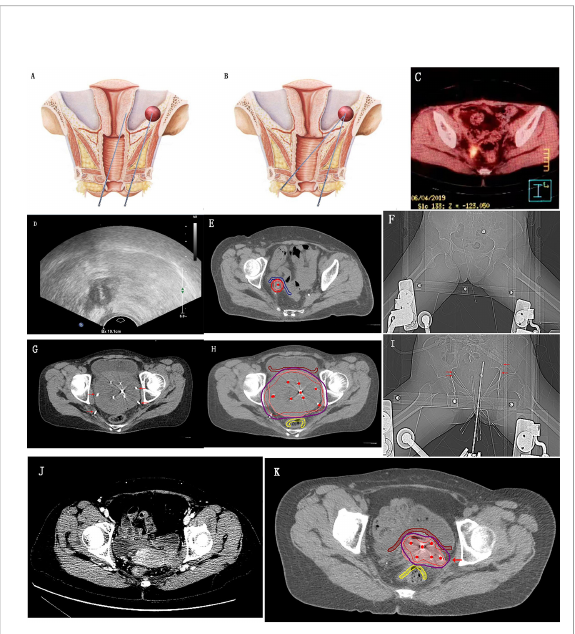
FIGURE 3 Transvaginal needle placement with the detachable puncture bracket. (A, B) Schematic diagrams of the pelvic cavity comparing the length of paths of transvaginal and perineal needle insertion; (C – F) Positron emission tomography/ computed tomography (CT) shows recurrent lesions adjacent to the right ureter in the pelvic radiation fi eld after cervical cancer surgery; ultrasound shows real-time ultrasound-guided transvaginal insertion of a needle into the tumor tissues; CT shows an accurate implant result and highly conformal high-risk clinical target volume; (G – I) CT shows the large pelvic mass implant; (J, K) Implant therapy for the periuterine invasion of cervical cancer. The needles indicated by the red arrow in the fi gure are the sites that can be implanted using a detachable puncture bracket under transvaginal ultrasound real-time